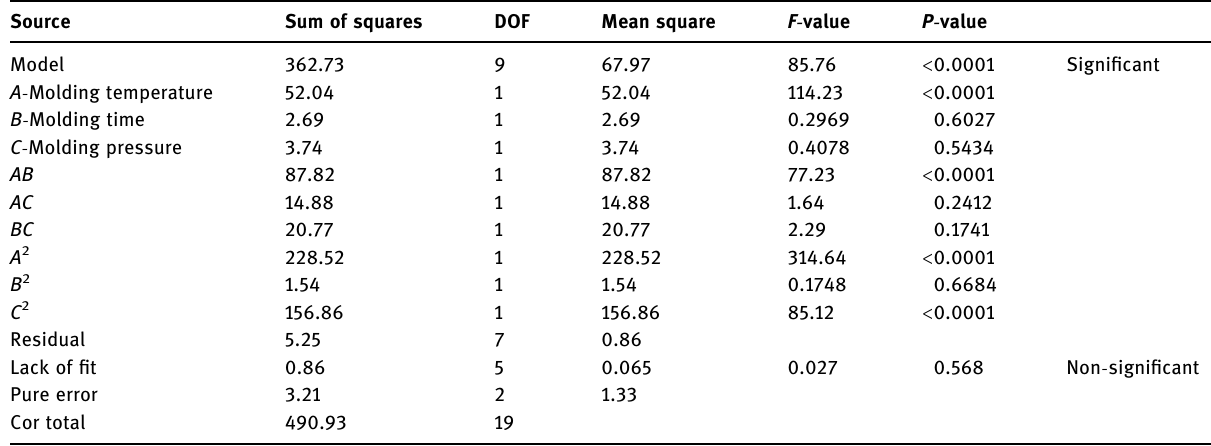
Table 13: ANOVA for hardness